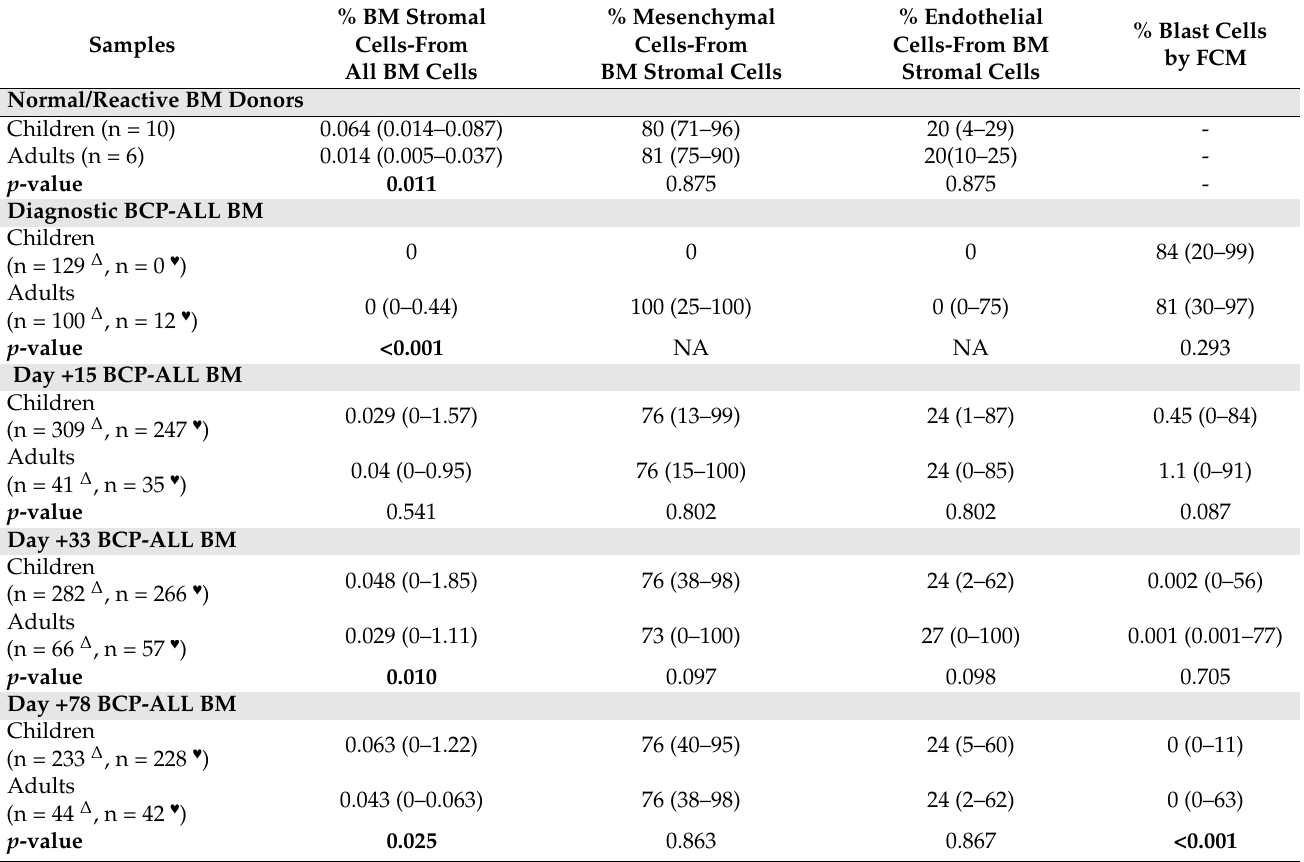
Table 1. Distribution of stromal cells in normal/reactive bone marrow (BM) and both diagnostic and follow-up BM samples from children vs. adult patients diagnosed with BCP-ALL.